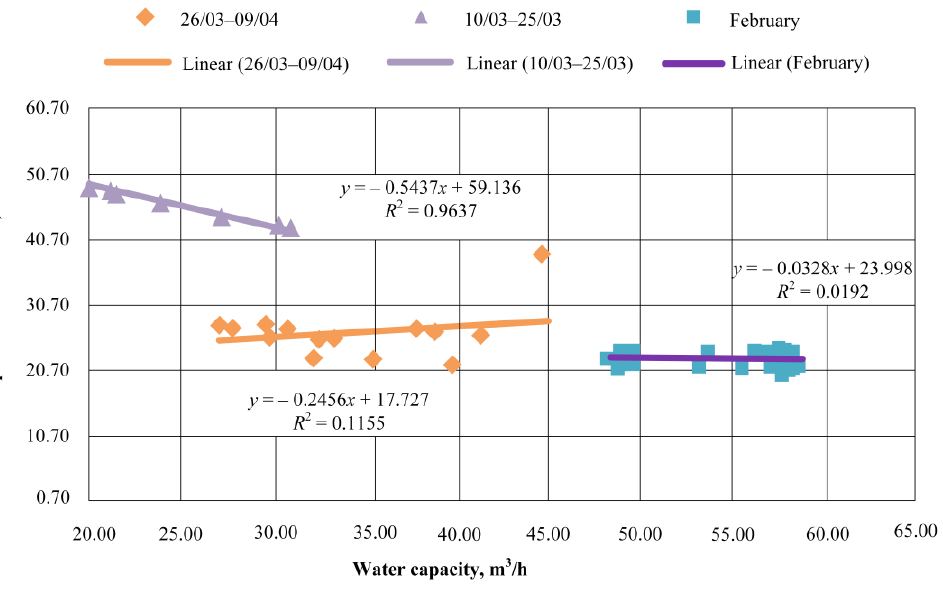
Fig. 9. Interaction of water temperature difference with mass flow rate in heat